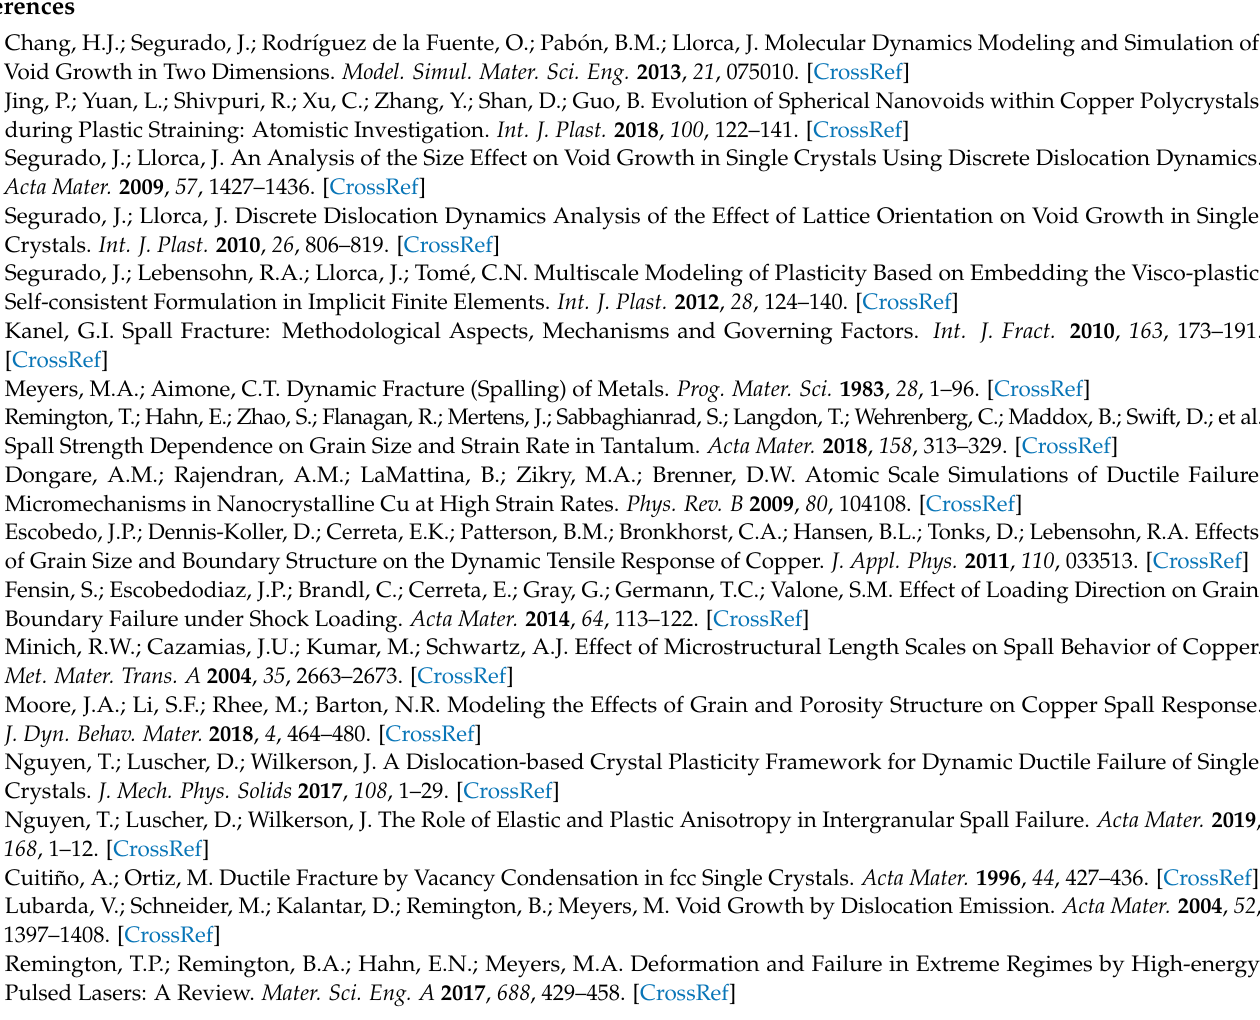
Figure S2—Damage (void volume fraction) evolution based on Meyer-JMAK treatment, with dif- . N o , as compared to MD results for [001] single-crystal Ta.; Figure S3—Snapshots ferent choices of of [001] single crystal Ta at different times.; Figure S4—Evolution of number density and volume fraction of voids for [001] single-crystal